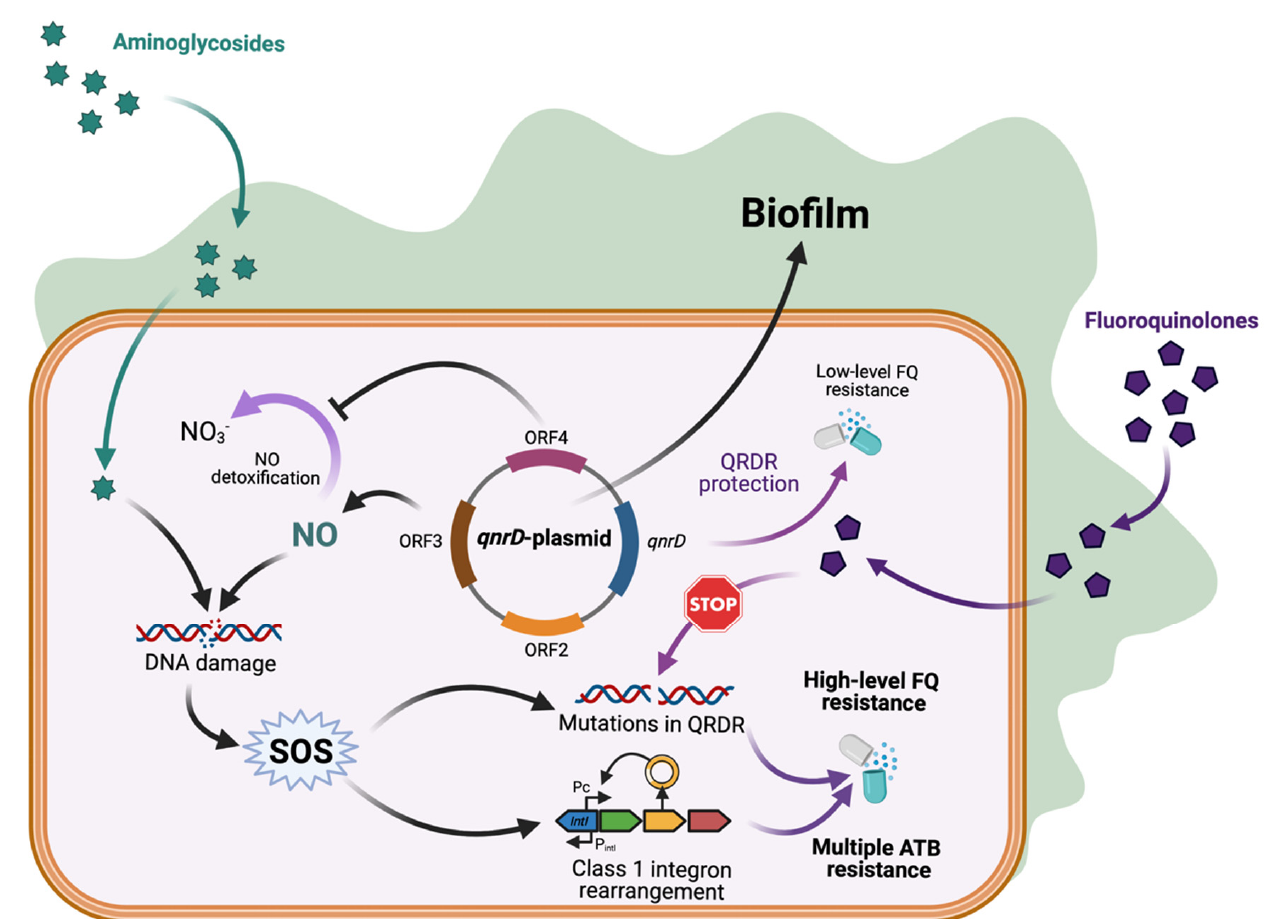
Figure 3. qnrD -plasmid promotes biofilm formation and class 1 integron rearrangement with anti- biotic resistance consequences. Enhanced biofilm formation by qnrD -plasmid favors exposure to sub-MICs. For fluoroquinolones it increases SOS-mediated qnrD expression and low-level of fluo- roquinolones resistance. For aminoglycosides, the NO accumulation-mediated SOS induction trig- gers mutagenic response and class 1 integron rearrangement, both leading to potential multiple an- tibiotic resistance. Created with BioRender.com (accessed on 10 May 2022).